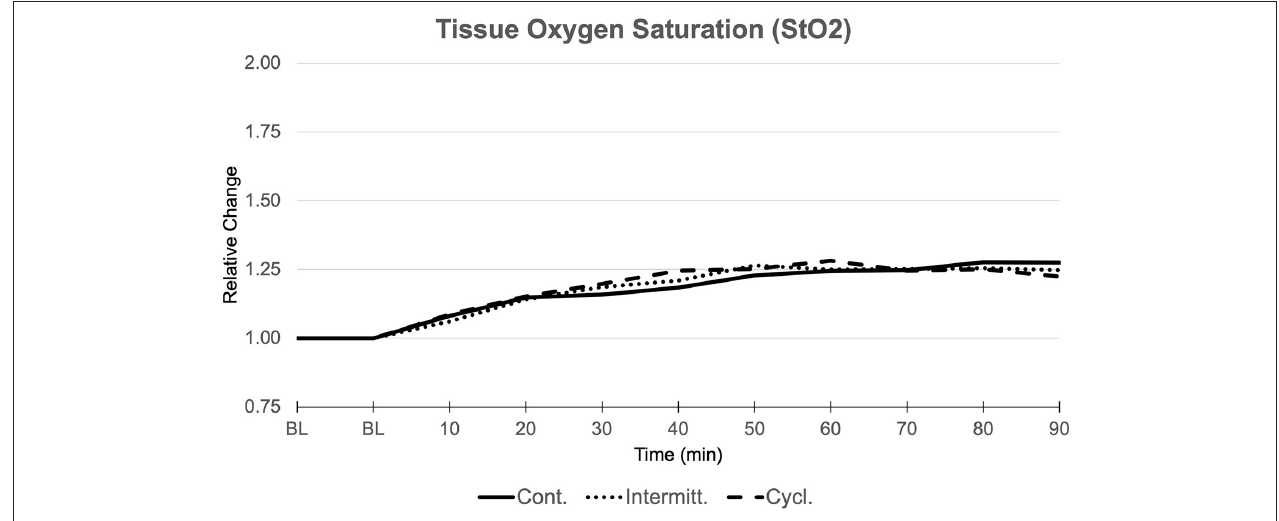
FIGURE 3 | Tissue Oxygen Saturation (StO 2 ). Relative changes compared to baseline values (BL, 1.000) over the course of measurements (min) in all three